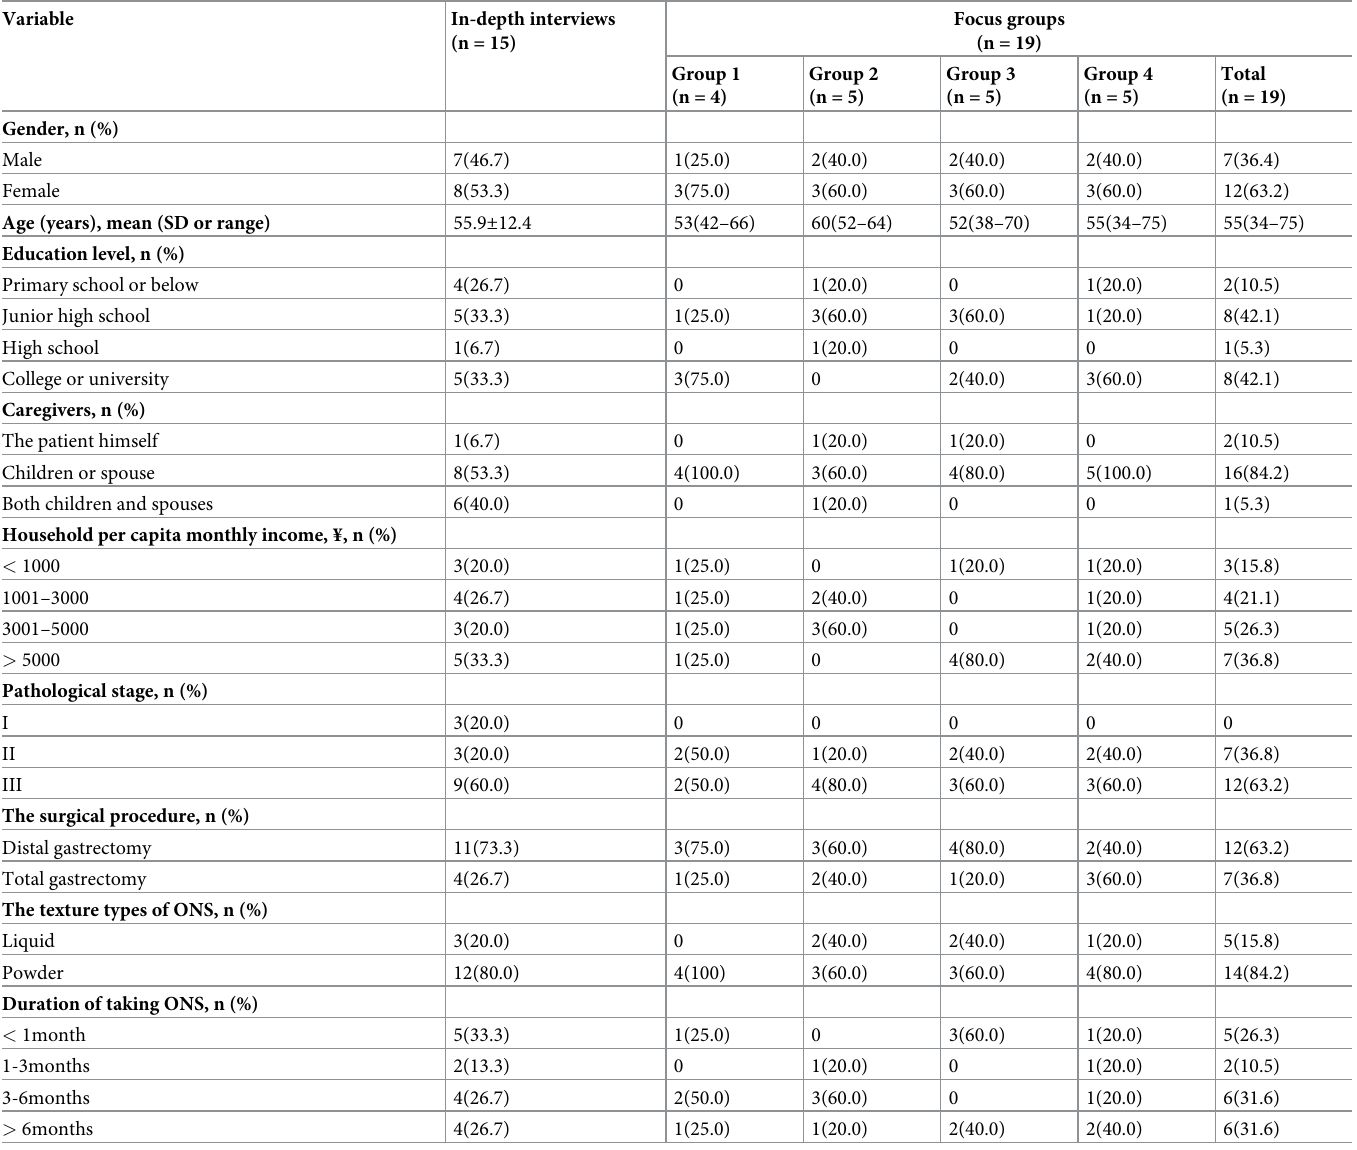
Table 3. Patients’ sociodemographic and clinical